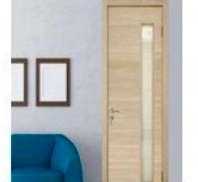
Figure 7. Example of the retrieval result of the BIM door model outline drawing.